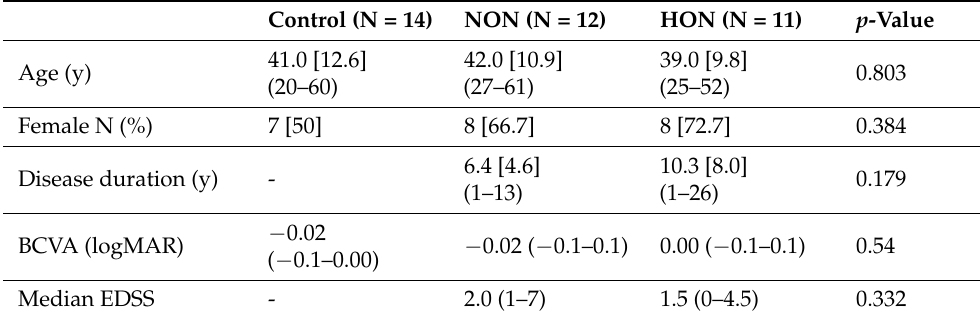
Table 1. Demographic and clinical characteristics of the participants.